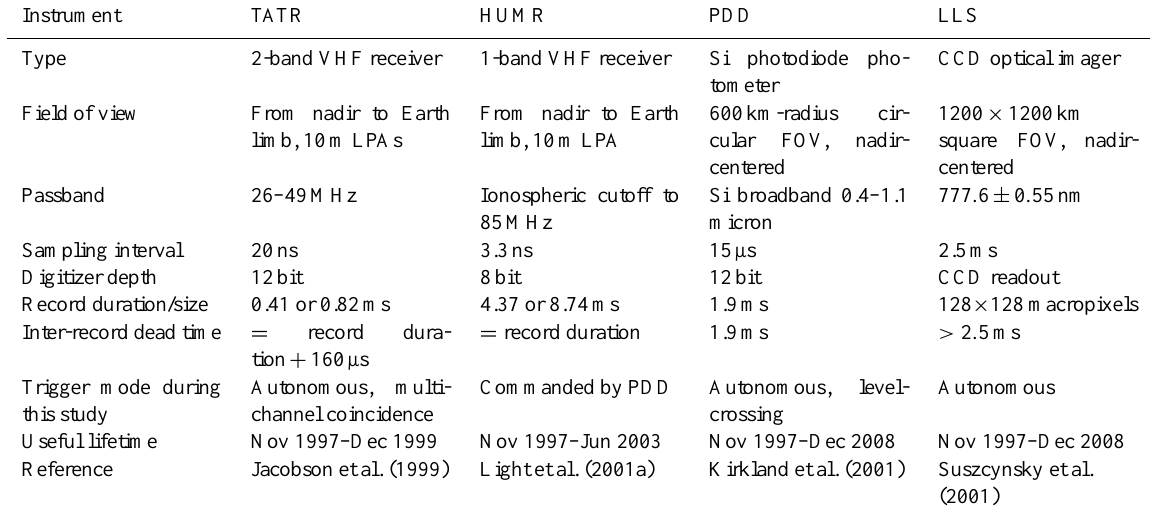
Table 1. FORTE instrument characteristics for this